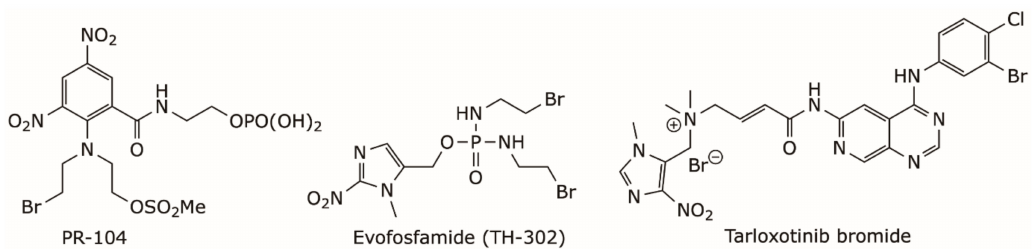
Figure 2. Chemical structure of some hypoxia-targeted nitro(hetero)aromatic-based prodrugs.